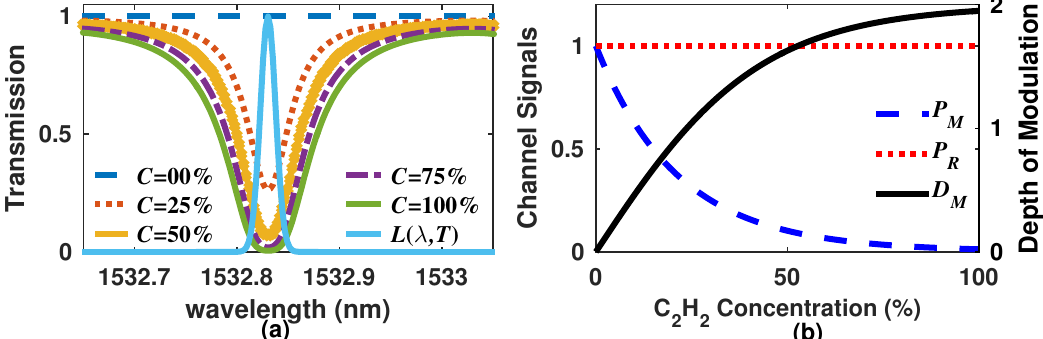
Figure 2. ( a ) Simulated laser emission profile and C 2 H 2 transmission spectra considering a path length of 5 cm and different concentrations. The simulated laser spectrum was normalized to 1 for clarity purpose. ( b ) Simulated measurement and reference signals and their corresponding depth of modulation as a function of the C 2 H 2 concentration.